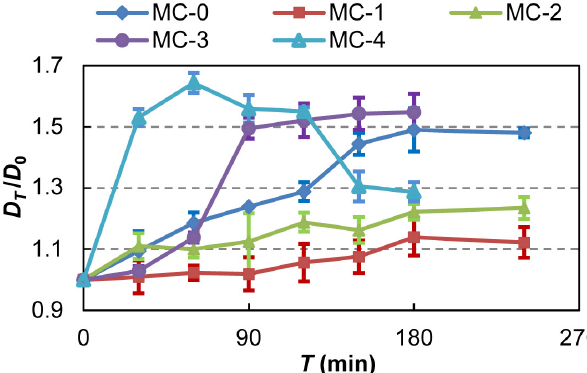
4 h later, the netlike agglomerates of MWCNTs